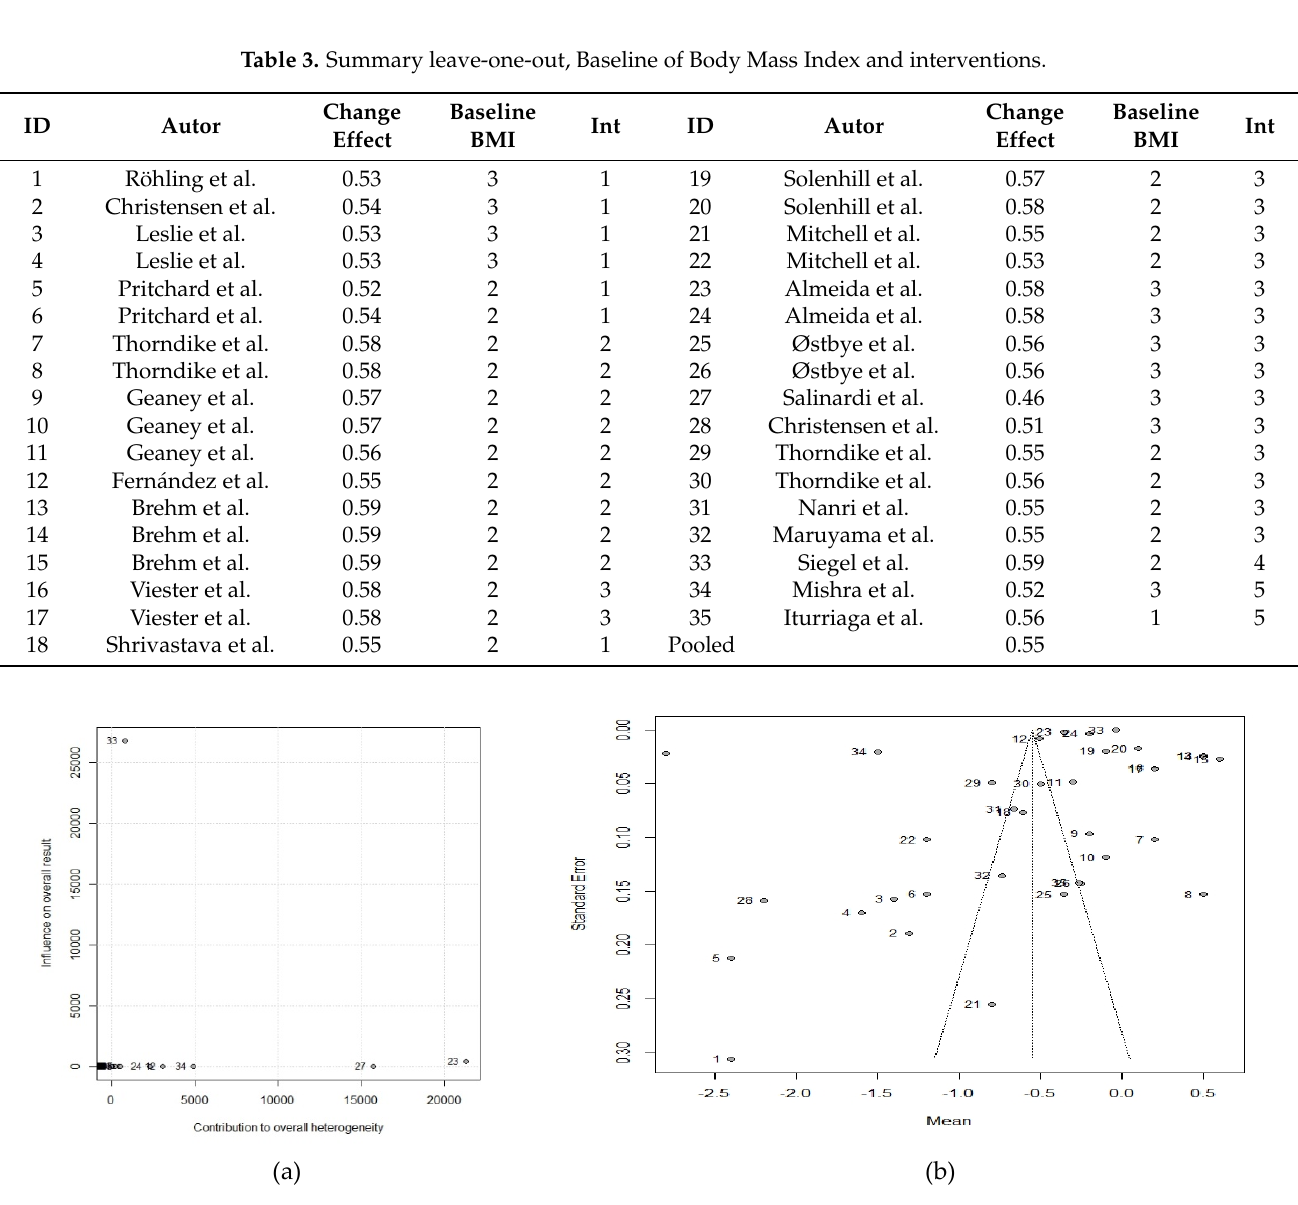
Table 4. Moderator analysis, adjusted meta-regression by the baseline of Body Mass Index and interventions. Variable Baseline BMI Sig.